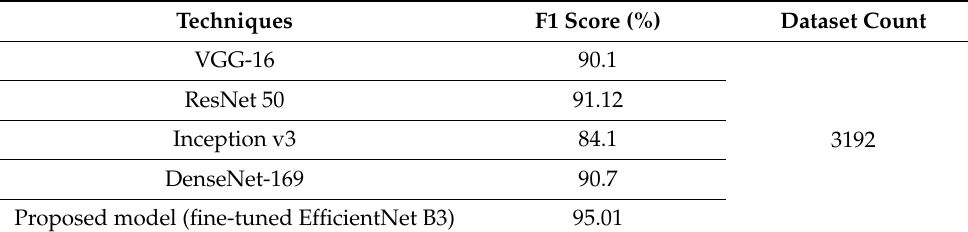
Table 10. f1 score calculation for detection of monkeypox disease detection results using the rein- Table 8. F1 score calculation for detection of monkeypox disease forcement learning approach.